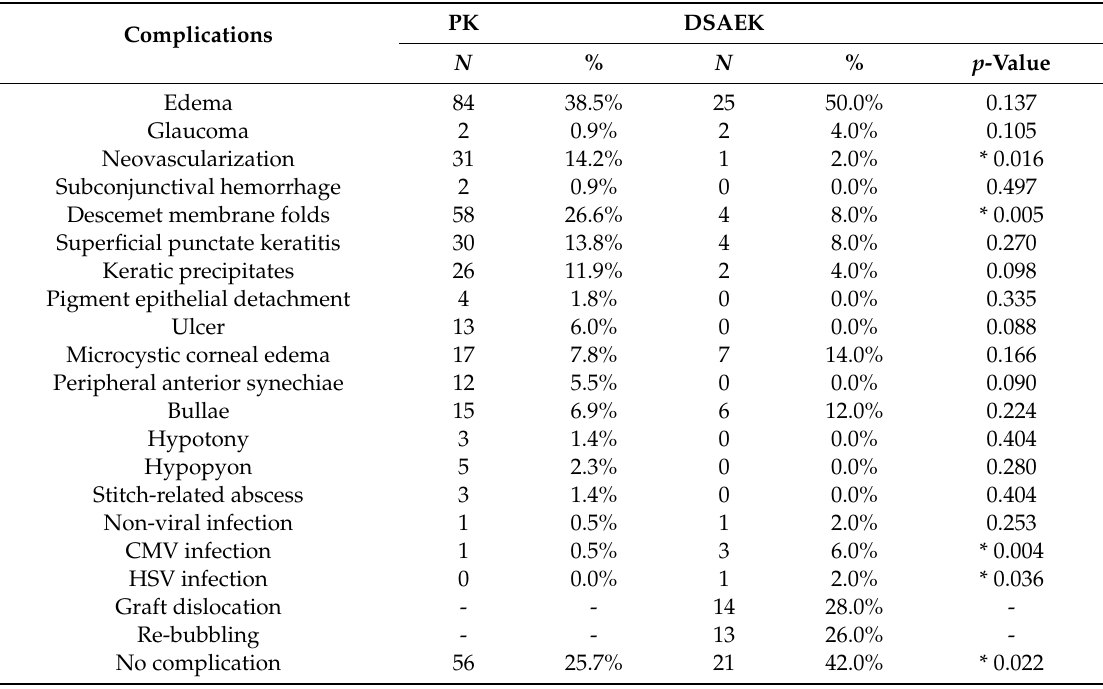
Table 5. Complications of PK and